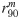
Metabomatching results on simulated metabolomes.A. Metabomatching performance, measured as r90m, the 90th percentile of 1 000 ranks obtained for m by metabomatching pseudospectra build from the association with M0, for β = 0.2 (filled dots) and β = 1.6 (empty dots), as a function of the size of the metabolite spectrum.For β = 0.2, the correlation between r90m and sm is −0.71, with p ∼ 10−26. B. As in (A), but for metabolome Mα, with β = 1.6, Na = 64 and α = 0.6. C. For UMDB and δ = 0.02, number of match sets (η) that contain each feature (uniform binning in 0.01 ppm increments). D. Metabomatching performance, measured as r90m, for Mα, with β = 1.6, Na = 64 and α = 0.6, as a function of η of the leading peak of the metabolite spectrum, that is the peak with hj = 1. Metabolite sizes are rounded. For sm = 1, 2, and 3, respectively, correlations ρ are 0.86, 0.79, and 0.76, with p-values ∼10−10, 10−4, and 10−4.